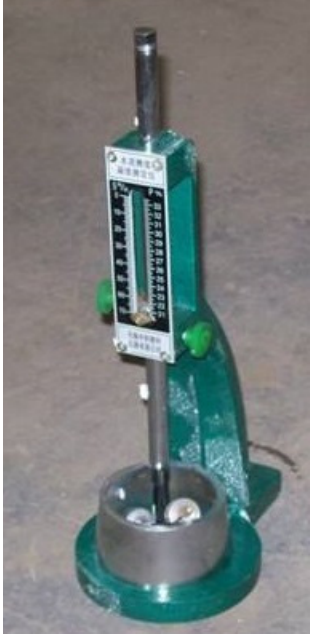
Figure 4. The Vicat apparatus.